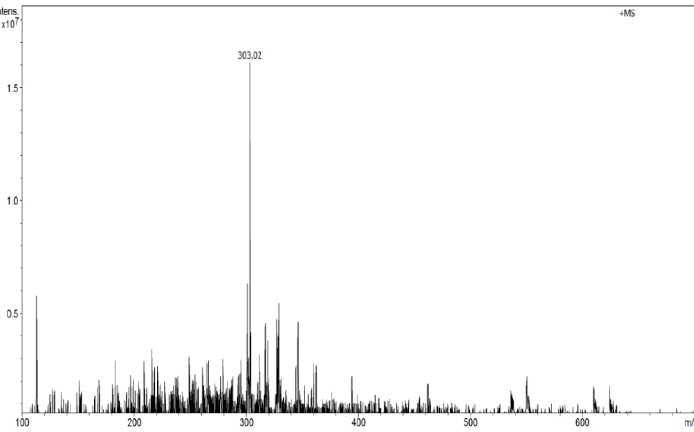
Figure 10. FAPA-MS spectrum of Q-MIP in the ranges of negative ions ( m/z 301 [M − H] − ). The analytical results of helium plasma ionization source FAPA-MS experiments were obtained with the use of a solution of pure quercetin. Experiments were repeated three times. The relative standard deviation (RSD) obtained for all data did not exceed 15%. In order to determine the background signals, the spectra of particular matrices (NIPs) without the analytes were recorded. The limit of detection (LOD) is the concentration of a substance below which its identity cannot be distinguished from analytical artefacts. The limit of detection (LOD) was calculated according to the definition: LOD = mean blank value + 3 × standard deviation. The m/z signal of the analyte was three times higher than that of the noise level. In the experiments in which the LOD of pure compounds was determined, 20 μ L of the solution of the analytes at different concentrations in methanol were introduced into the crucible and heated to about 300 °C. In the context of an analysis system, the linearity means that we assume a linear relationship between the concentration of analyte (x) and intensity of m/z signals (y), which can be written mathematically as y = f(x). It is a common practice to check the linearity of a calibration curve by inspection of the correlation coefficient (R 2 ). A correlation coefficient close to unity (R 2 = 1) is considered sufficient evidence to conclude that a perfect linear calibration has been achieved. Using different concentrations of pure analytes, different weights of the solid matrices with the analyzed compounds, it was found that the linearity of the analyte determinations was satisfied when the correlation coefficient of the function y = f(x) was greater than R 2 = 0.9850. On the basis of measurements made for Q-MIP and Q-mag-MIP systems containing different amounts of quercetin, it was established that the signal intensity dependence on